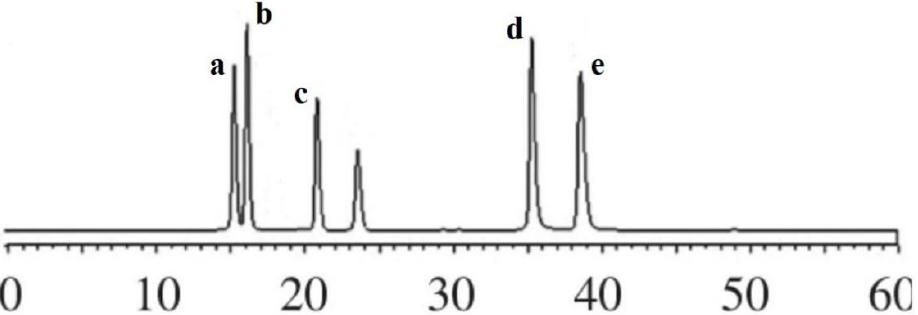
Figure 4. The chromatograms of flavonoid compounds from NADES by HPLC. a, coumarin; b, kaempferol; c, genistein; d, quercetin; e, luteolin.